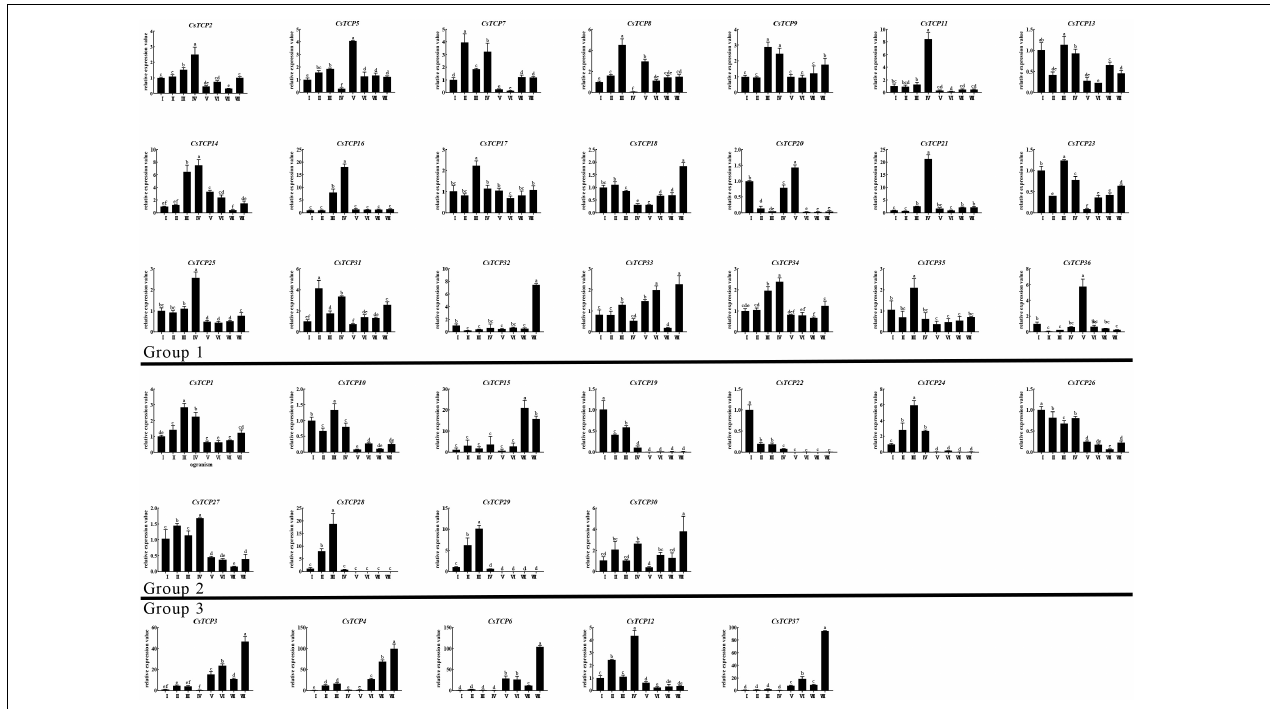
FIGURE 7 | CsTCP genes expression patterns in eight